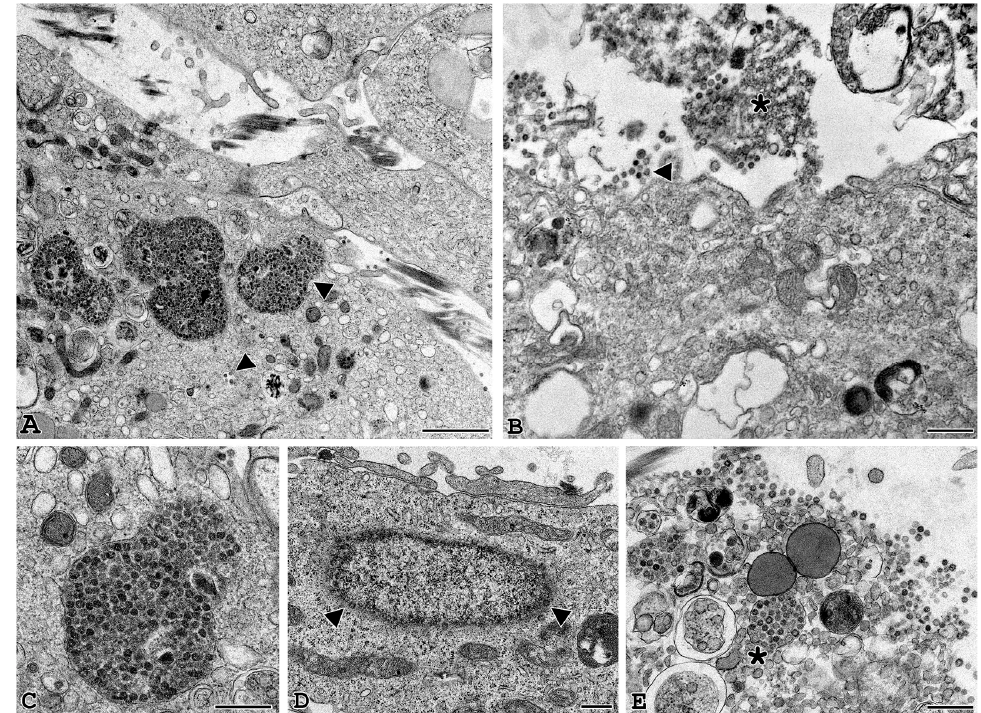
Figure 5. Longer exposure to SARS-CoV2 induces cell suffering and death. Representative electron microscopy images of granulosa cells at 48 h ( A – D ) and 72 h ( B – E ) post-infection. At 48 h, vesicles containing a large number of viral particles ( A – C ) are observed in the cellular compartment where the first signs of cellular suffering appear (asterisk). In addition, viral particles are seen near the nuclear membrane ( D ). At 72 h, cells appear ultrastructurally damaged ( B – E ) with clear signs of cell lysis and leakage of viral components. Arrowheads: viral particles. ( A , B ) bar = 1 μ m. ( C – E ) bar = 500 nm.